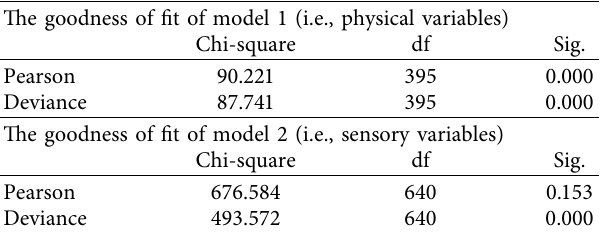
Table 6: The goodness of fit.